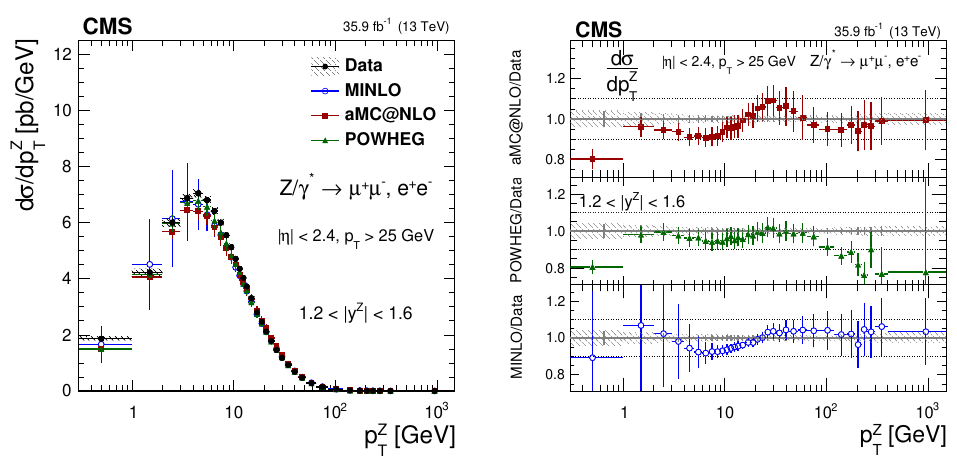
Figure 12 . The measured absolute cross sections (left) in bins of p Z for the 1 : 2 < j y Z j < 1 : 6 region. T The ratios of the predictions to the data are also shown (right). The shaded bands around the data points (black) correspond to the total experimental uncertainty. The measurement is compared to the predictions with MadGraph 5 a mc@nlo (square red markers), powheg (green triangles), and powheg - MINLO (blue circles). The error bands around the predictions correspond to the combined statistical, PDF, and scale uncertainties.